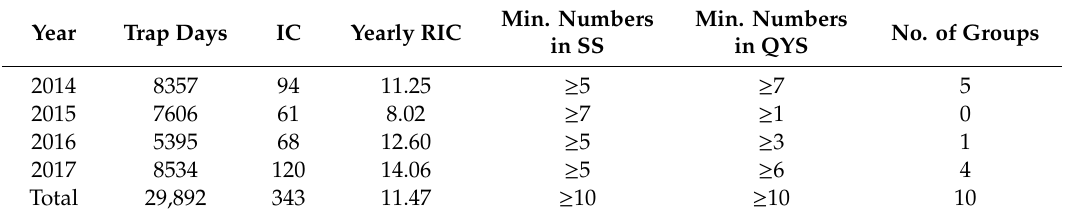
Table 1. Yearly relative independent capture and abundance of lynx based on camera